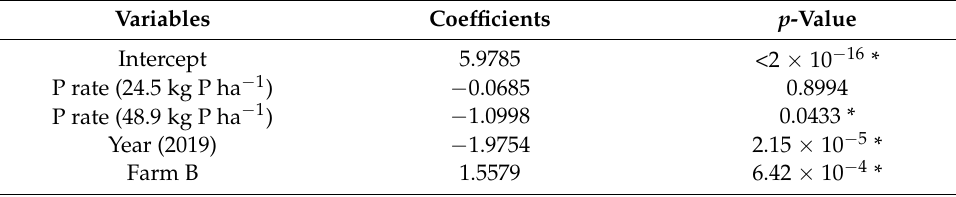
Table 12. Regression of total cull on P rate, year of measure, and farm. Variables Coefficients p -Value Intercept